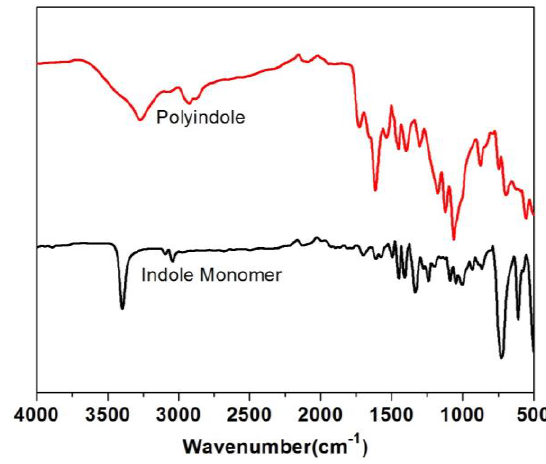
Figure A1. FTIR-ATR spectra of indole and